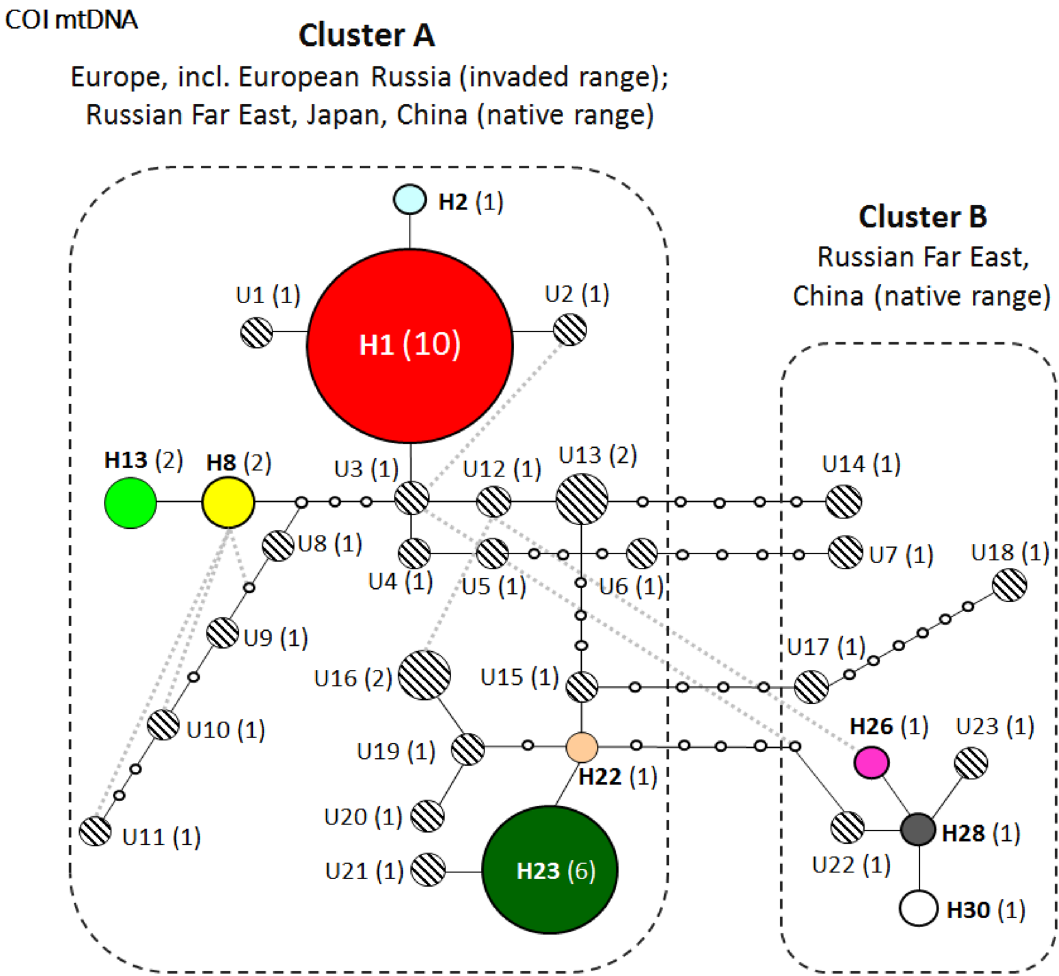
Figure 7. Median haplotype network of Phyllonorycter issikii in the Palearctic based on sequencing of 50 archival specimens dissected from historical herbarium collected between 1859 and 2014. Different colors correspond to nine haplotypes (H1, H2, H8, H13, H22, H23, H26, H28, H30) that are also known from modern Ph. isskii specimens 20 . Historical unique haplotypes (documented for the first time from archival specimens) are indicated by numbers U1–U23 next to the corresponding circles with shading. Empty tiny circles indicate intermediate missing haplotypes. The number of sequenced individuals is given in brackets next to each haplotype. Each line connecting the circles indicates one mutation step. Dotted rectangles indicate the two main clusters. The geographical distribution of haplotypes is given in Tables S5,